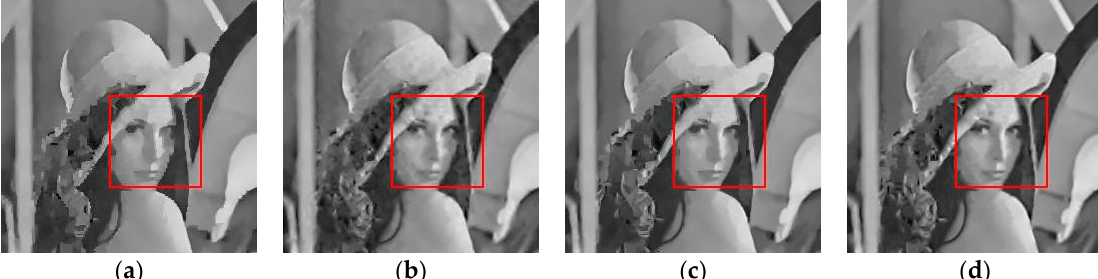
Figure 3. Lena image measurement rate = 0.1. ( a ) Reconstructed image by traditional TV, PSNR =26.272 dB, and SSIM = 0.789; ( b ) Reconstructed image by only fractional-order (order = 1.7) TV, PSNR = 26.956 dB, and SSIM = 0.809. ( c ) Reconstructed image by only higher-order (weight = 0.7) TV, PSNR = 26.670 dB, and SSIM = 0.803. ( d ) Reconstructed image by high-order (weight = 0.7) and fractional-order (order = 1.7) TV, PSNR = 27.493 dB, and SSIM = 0.829.